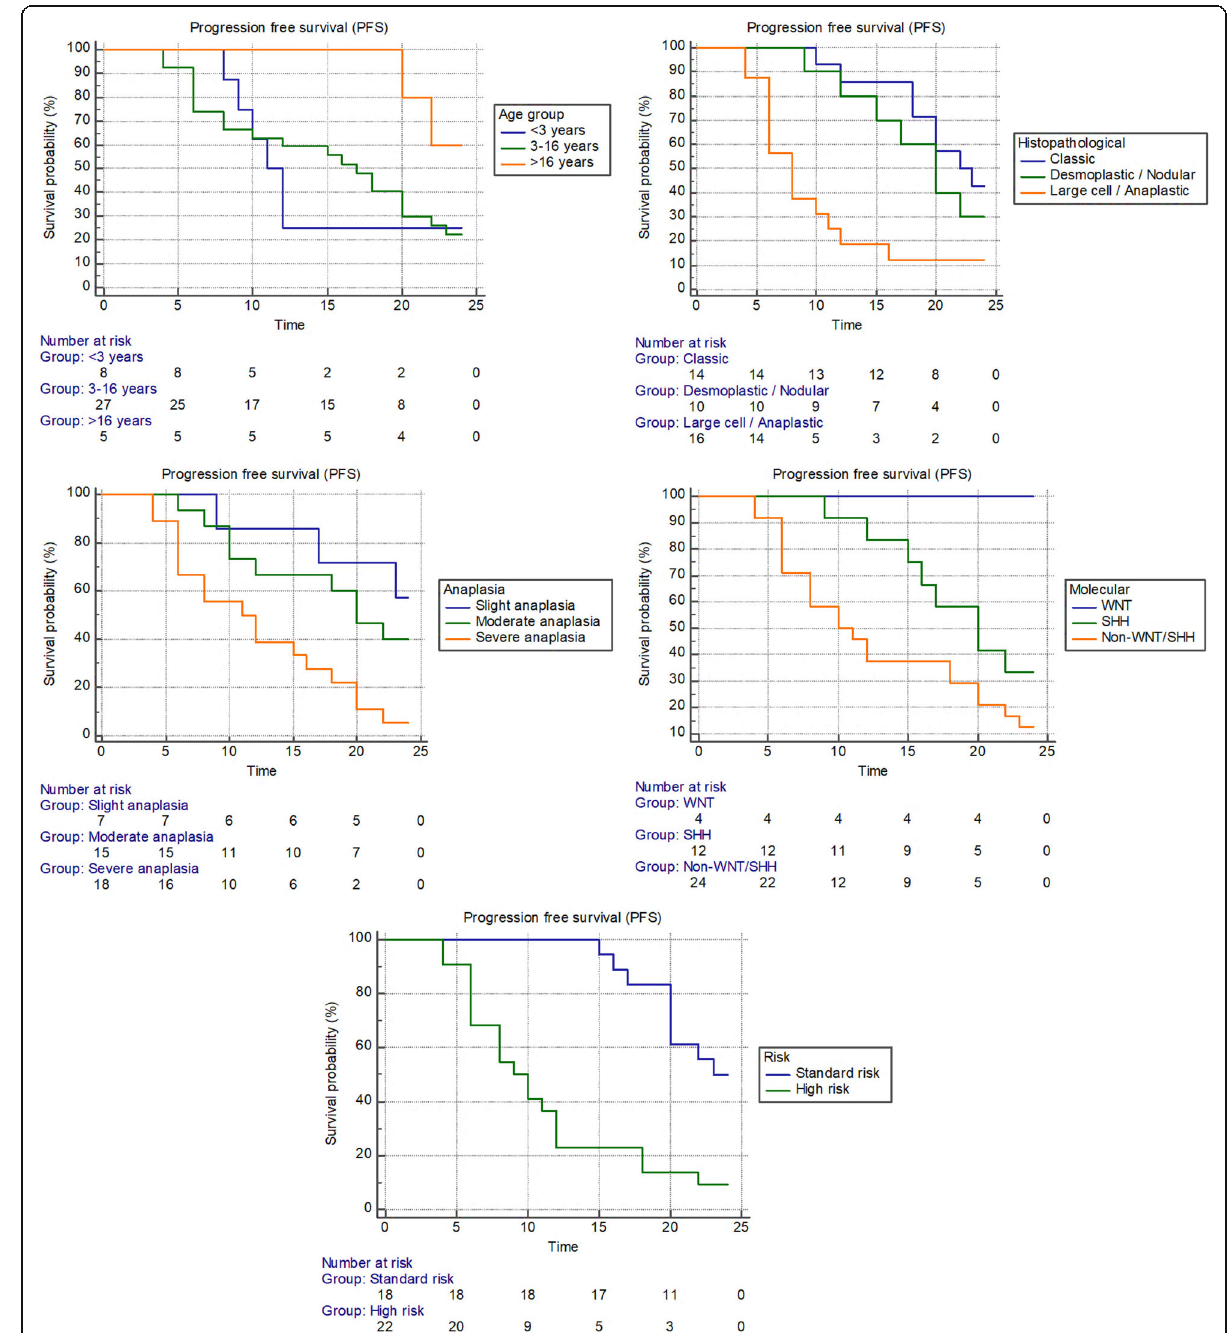
Fig. 4 Kaplan-Meier curves for progression-free survival (PFS), in relation to age group, histopathological types, degree of anaplasia, molecular subgroups, and risk